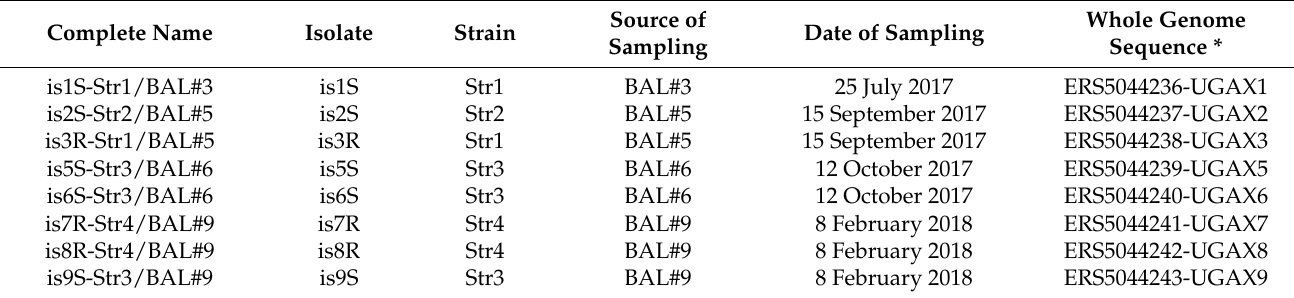
Table 2. Eight Achromobacter xylosoxidans isolates for which whole genome sequencing was carried out. These were isolated from bronchoalveolar lavages in a 12-year-old boy after double lung transplantation. The patient received a first round of phage administration on 8 September 2017. A second round of phage treatment was performed on 23 January